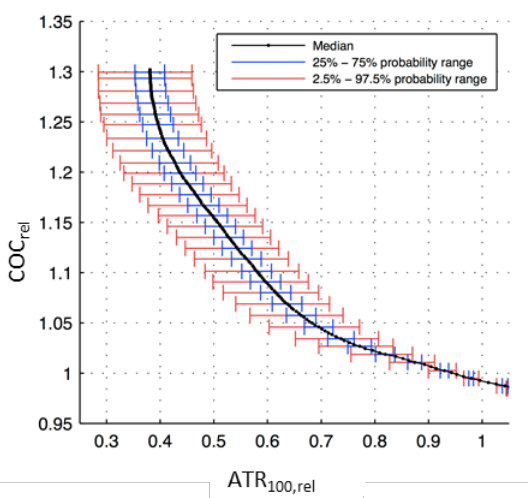
Figure 8. Pareto front of total mitigation potentials and costs (ATR rel , all vs. COC rel , all ) for all analyzed routes expressed relative to the reference case